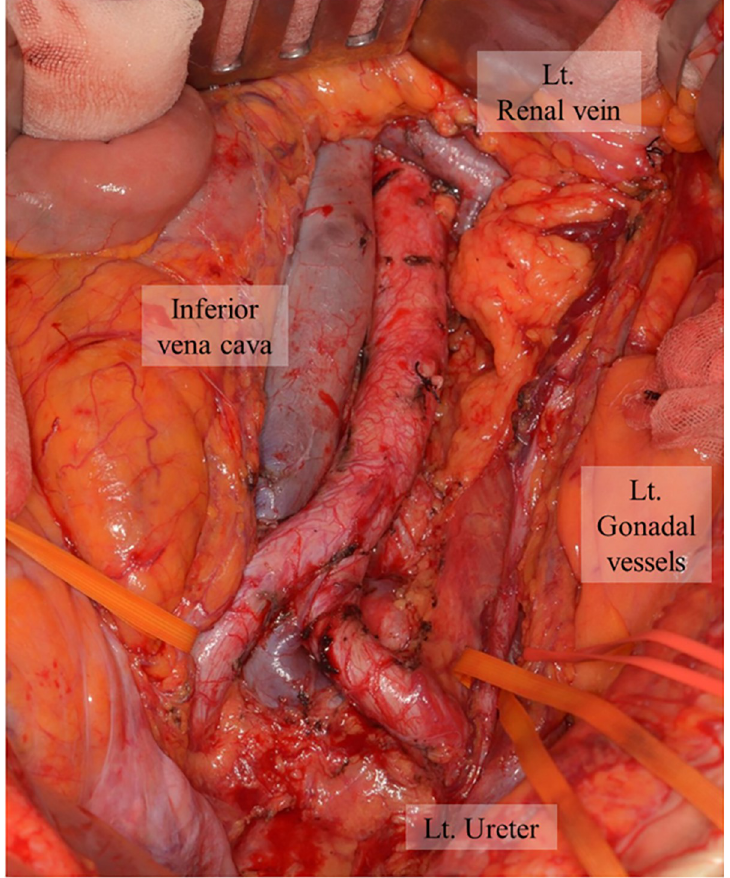
Fig 1. Intraoperative findings of PALN dissection. All lymphovascular structures were removed from the lower border of the left renal vein, the right border of the inferior vena cava, and the right border of the left gonadal vessels. PALN, para-aortic lymph